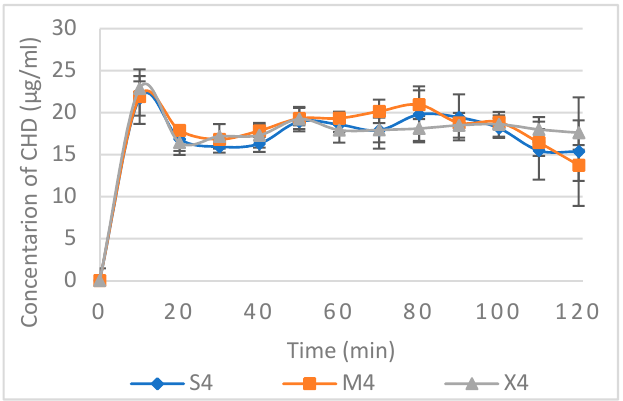
Figure 5. Non-cumulative CHD release from S4, M4, and X4 using CFR 1mL/min. Data are expressed as mean concentration ± SD, n = 3.